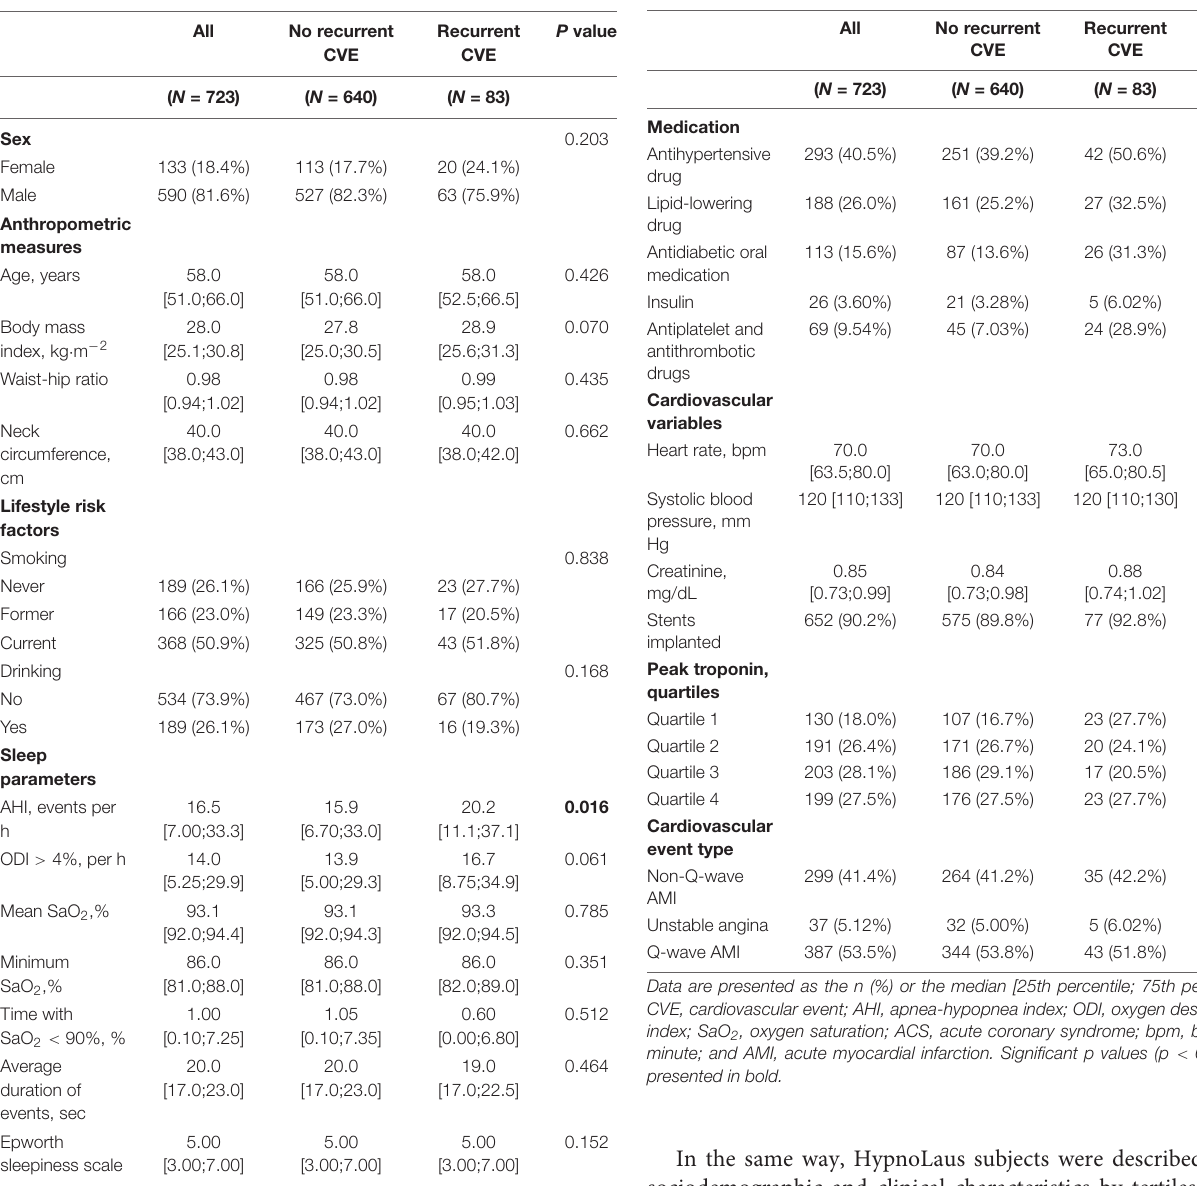
TABLE 1 | Baseline characteristics of patients from the ISAACC